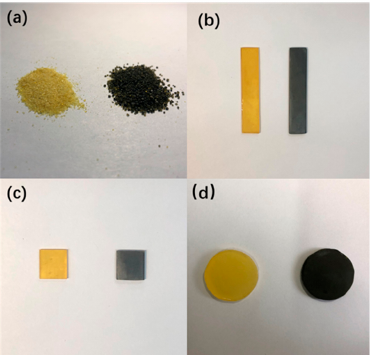
Figure 1. Specimens for ( a ) thermogravimetric analysis (TGA), ( b ) mechanical, ( c ) dielectric, and ( d ) dynamic thermomechanical analysis (DMA)